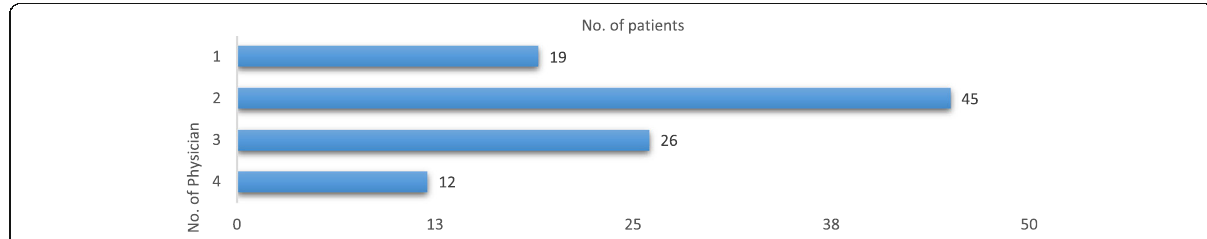
Fig. 3 Number of physicians consulted by patients before being correctly diagnosed as suffering from